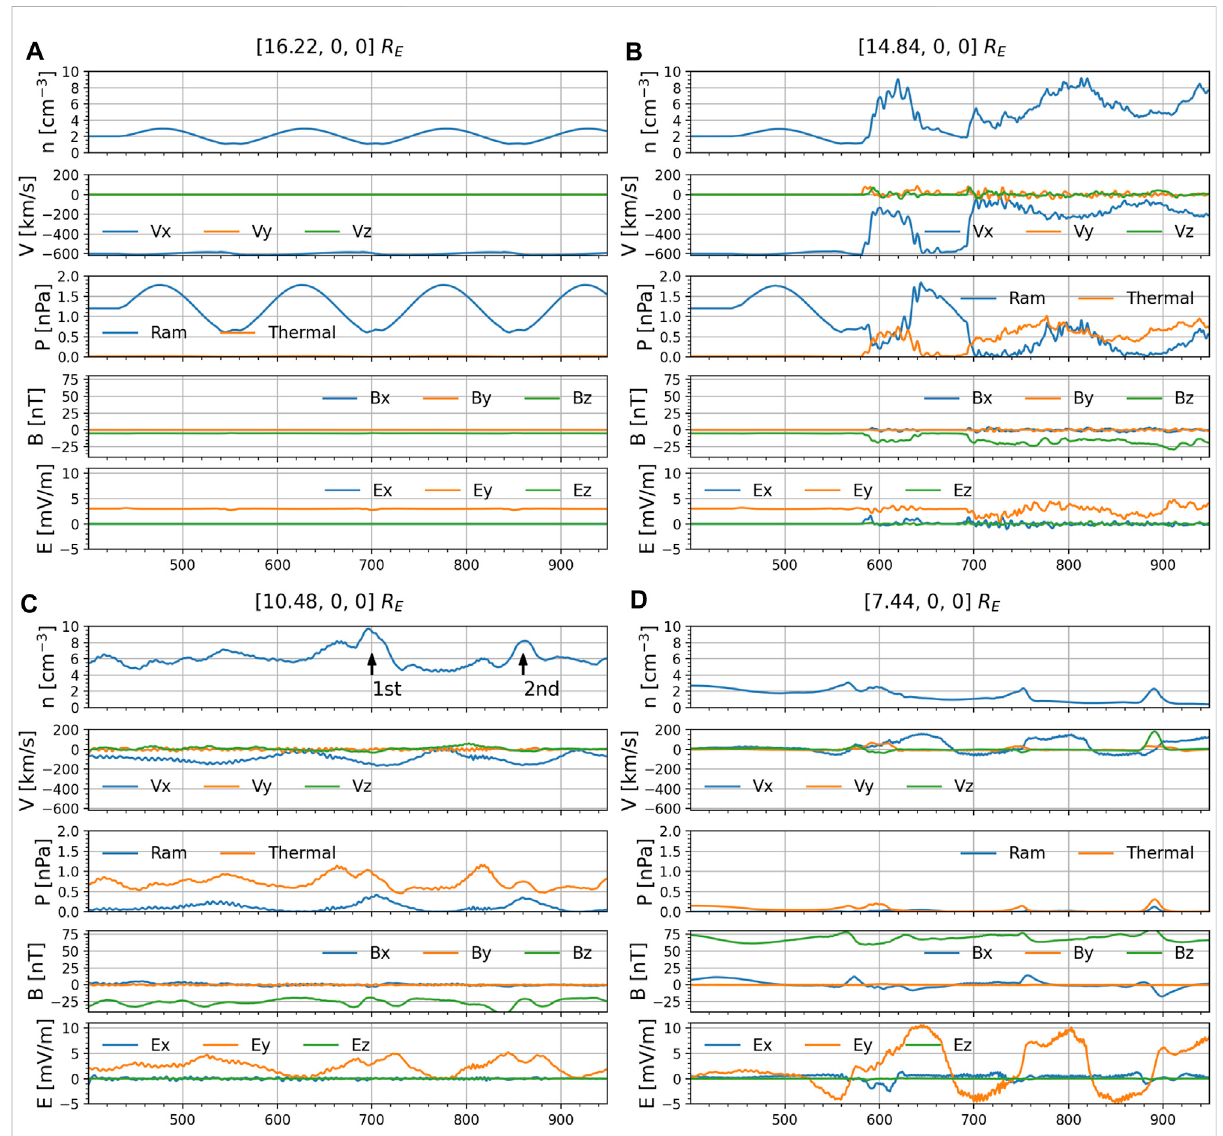
FIGURE 3 Virtual satellites tracking at four different locations along the subsolar line: (A) in the upstream solar wind, (B) across the bow shock, (C) in the middleofthemagnetosheath, (D) insidethemagnetosphere.Eachsatellite panelshows theplasmanumberdensity,velocity,dynamicrampressure, thermal pressure, magnetic and electric fi eld